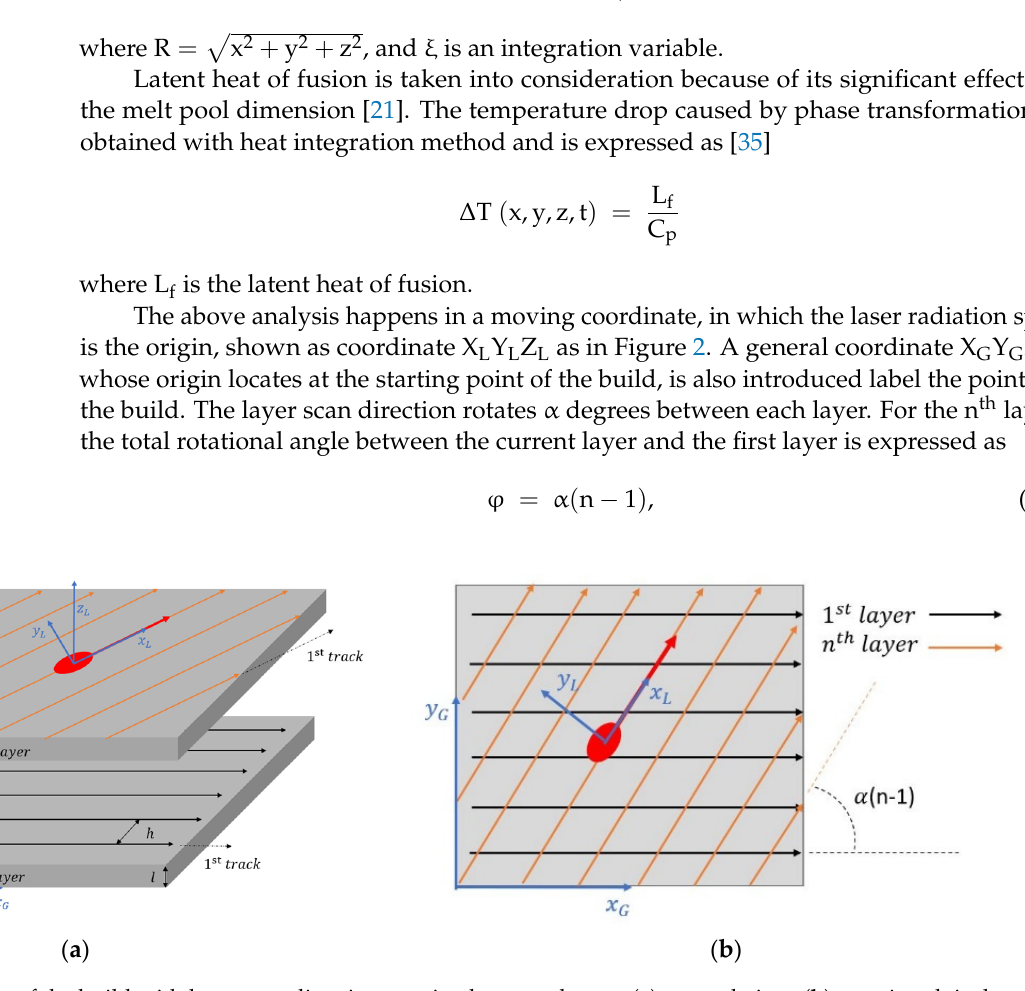
Figure 2. Illustration of the build with laser scan direction rotation between layers. ( a ) general view; ( b ) top view. h is the hatching space between layers. α is the laser scan direction rotation angle between each layer. l is the layer thickness.